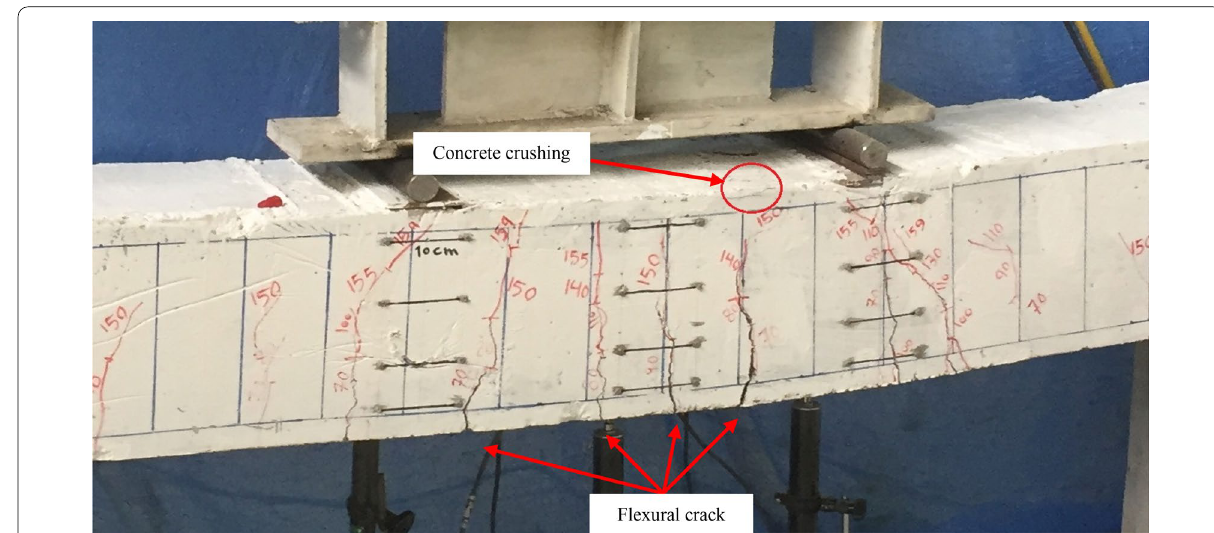
Fig. 10 Failure mechanism and details of failure modes of REF beam specimen.